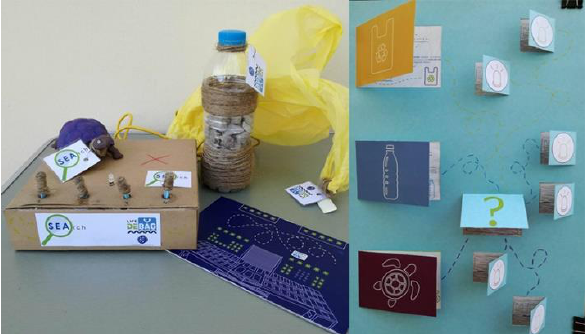
Figure 4. SEArch: Prototype Box, treasure map, NFC tagged objects,